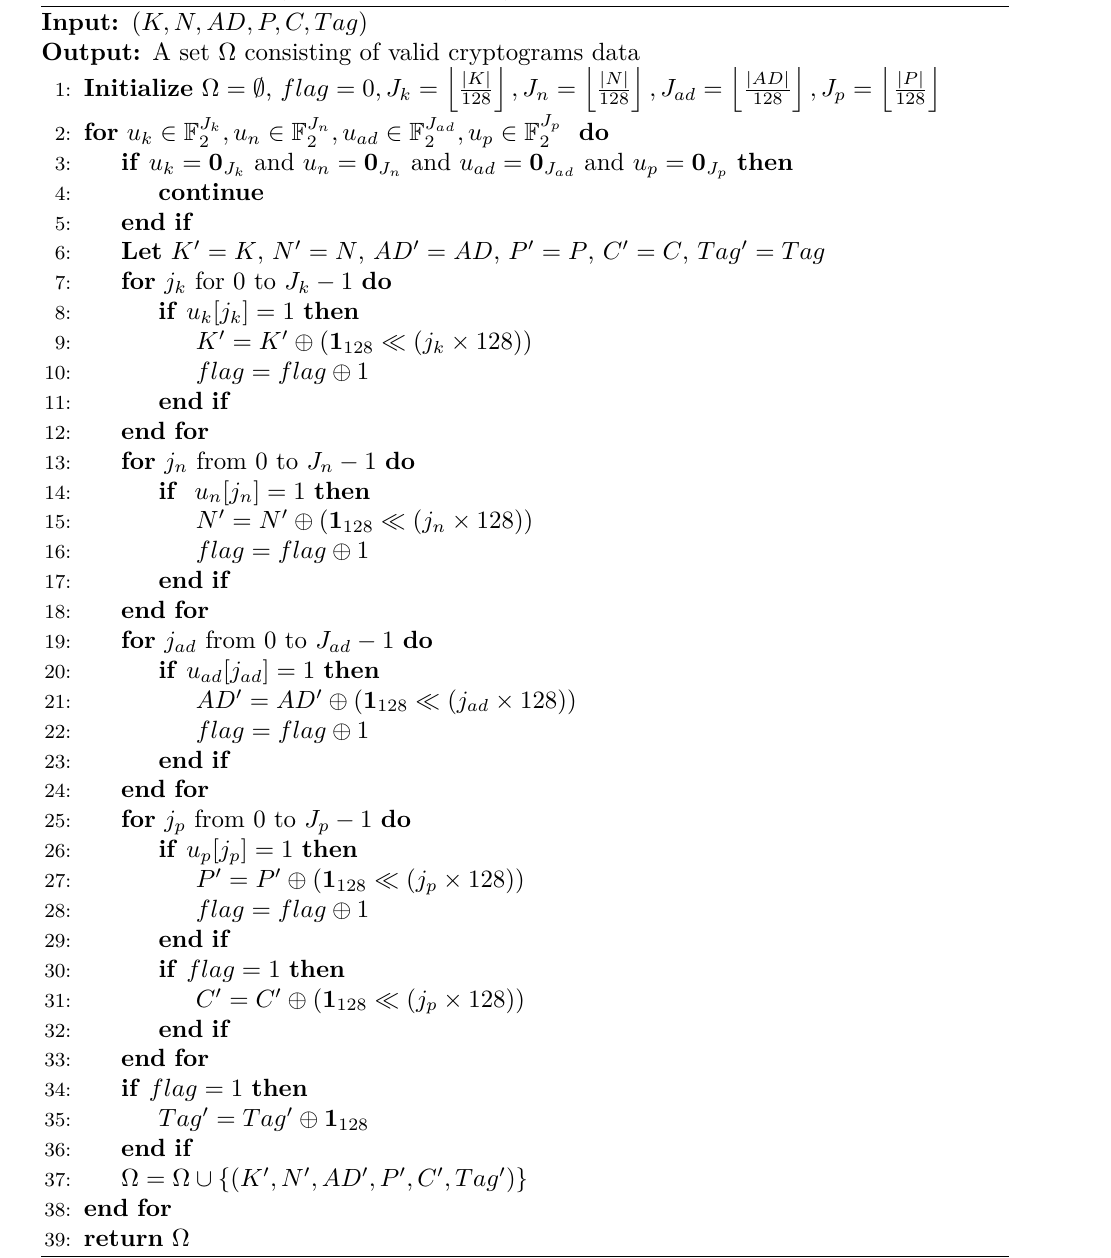
Algorithm 3 Attack ( K, N, AD, P, C, Tag